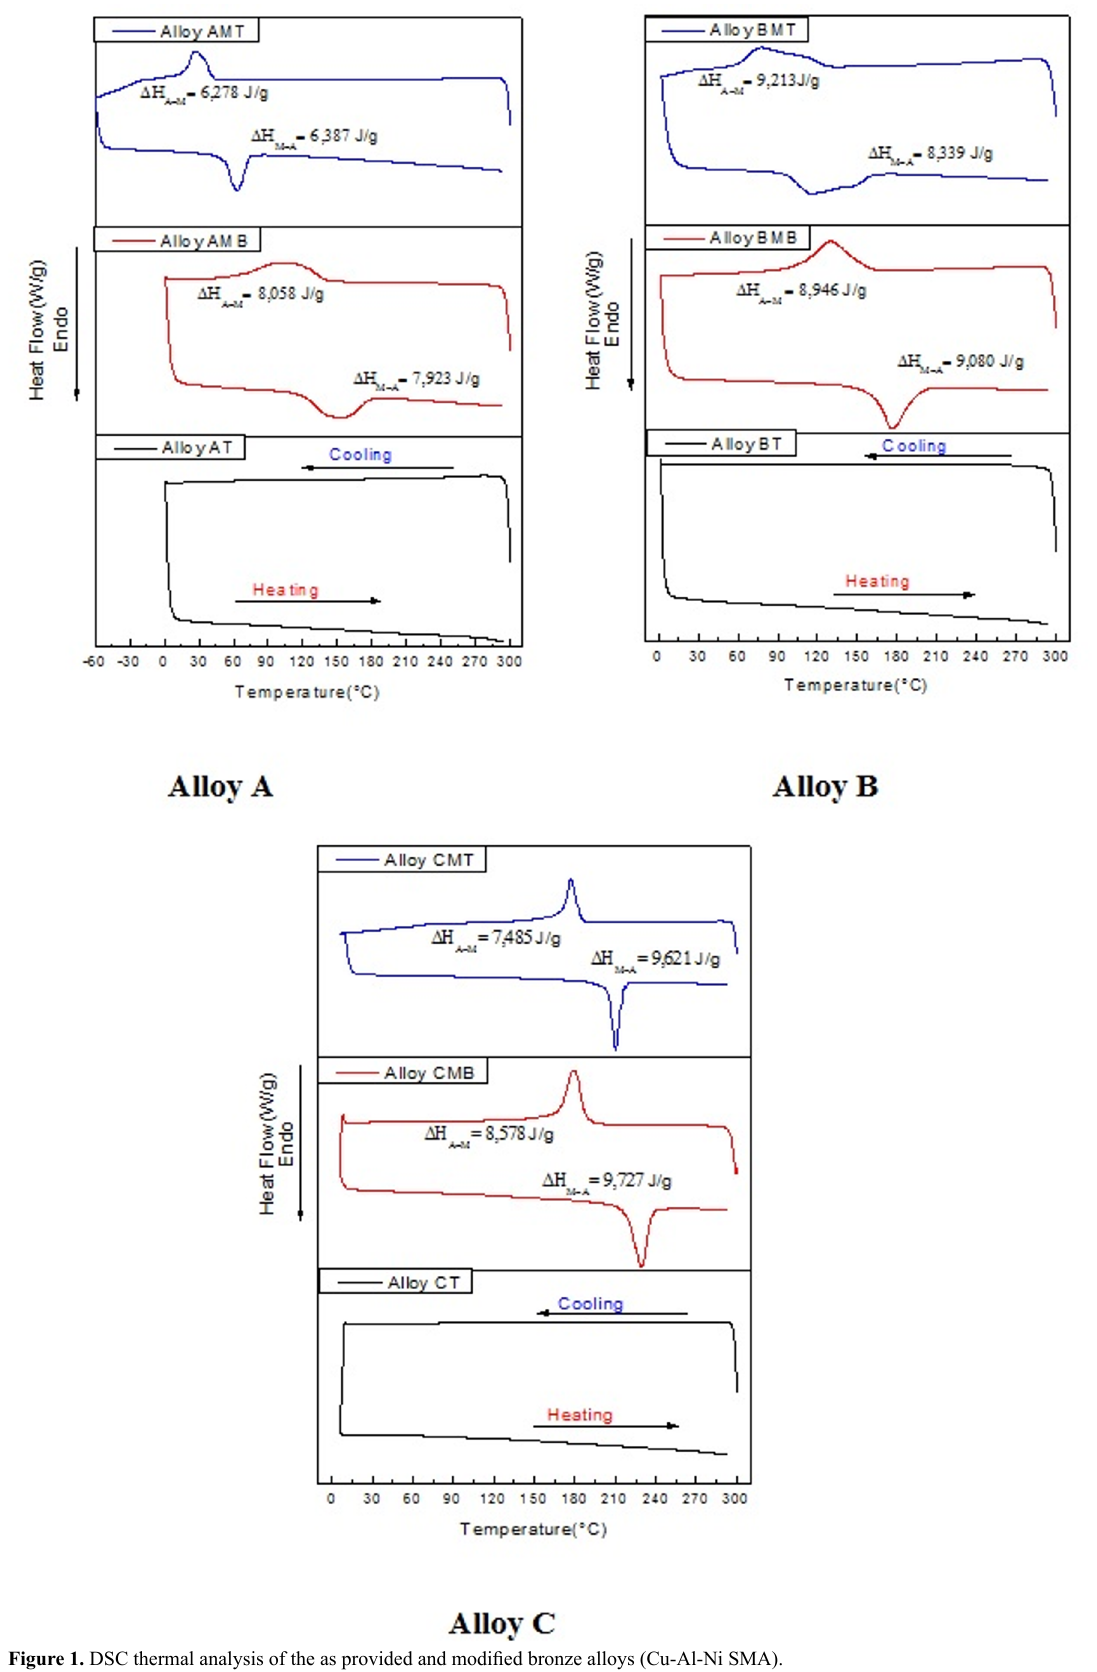
Figure 1. DSC thermal analysis of the as provided and modified bronze alloys (Cu-Al-Ni